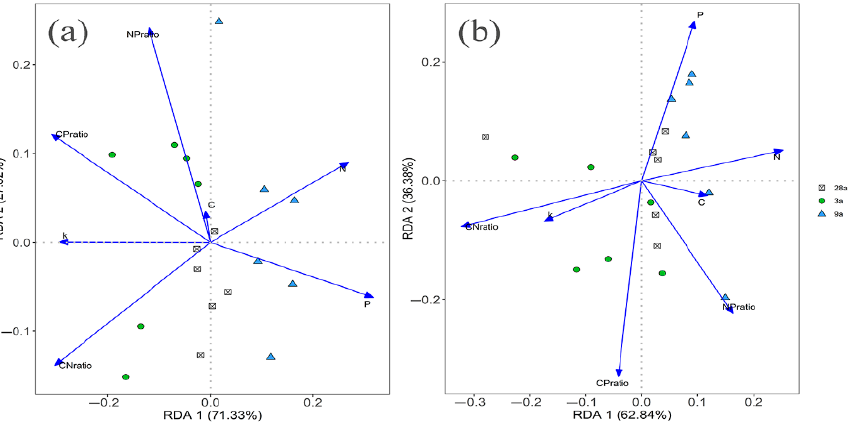
Figure 6. Redundancy analysis of leaf litter nutrients and stoichiometry and k values in burned and unburned control ( a ) and burned ( b ) stands of three different years postfire ( n = 3).